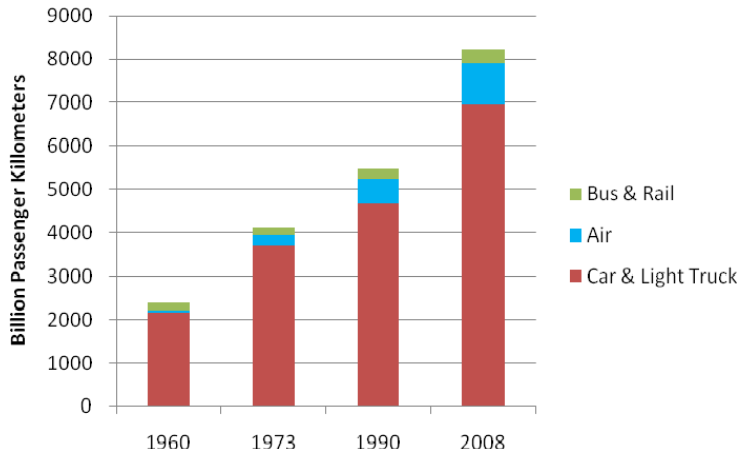
Figure 1. Total Passenger Travel by mode.